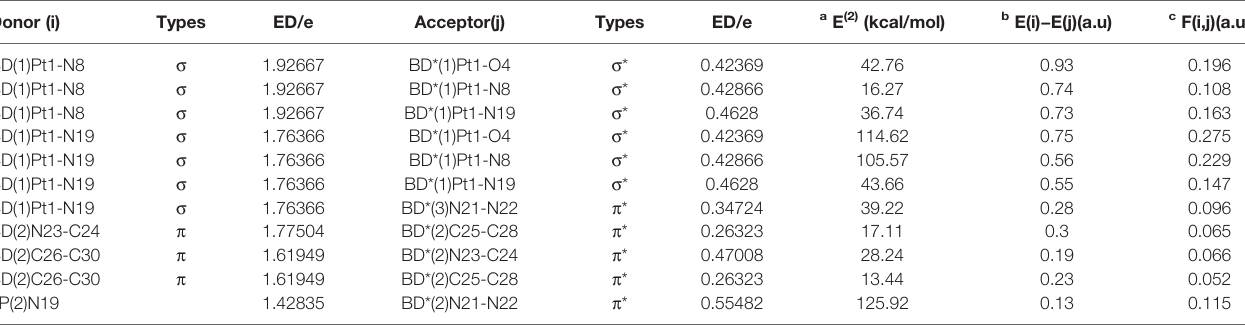
TABLE 6 | Second-order perturbation theory analysis of Fock matrix in NBO basis for compound 1 . Donor